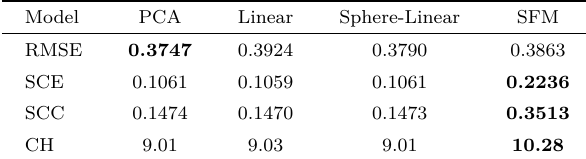
Results of model representation ability and its shape parameter separability in Bosphorus